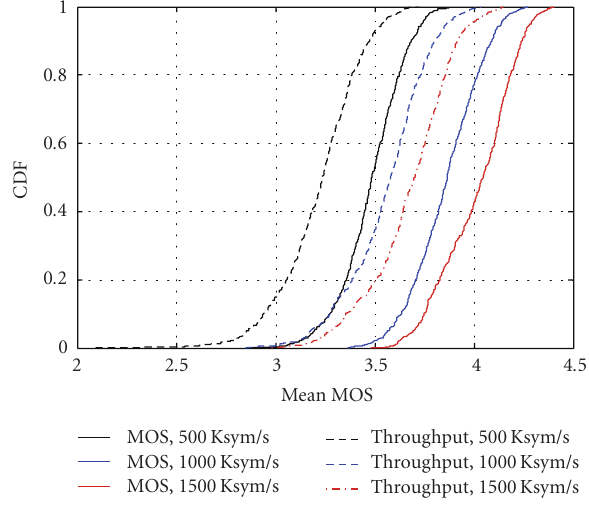
Figure 7: Mean opinion score of all seven users for three di ff erent total symbol rates (500, 1000, and 1500 Ksymbol/s) and two di ff er- ent optimization techniques, MOS maximization and throughput